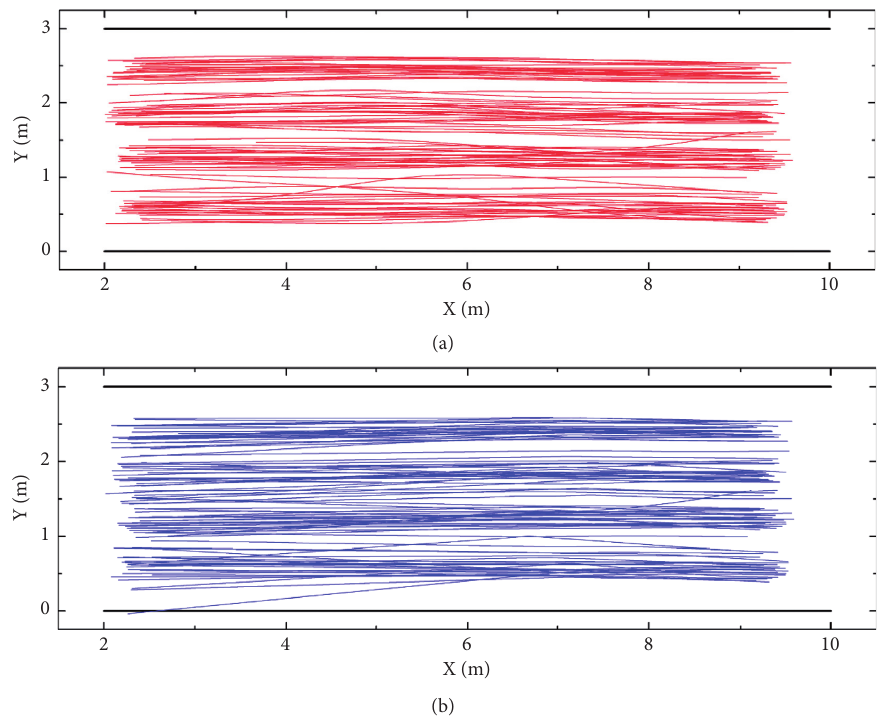
Figure 10: Comparison of predicted and real pedestrian trajectories in the unidirectional flow scenario, in which pedestrian positions of the first five time steps are used as historical movement for the reference of initial simulation. (a) Pedestrian trajectories in the experiment. (b) Pedestrian trajectories in the